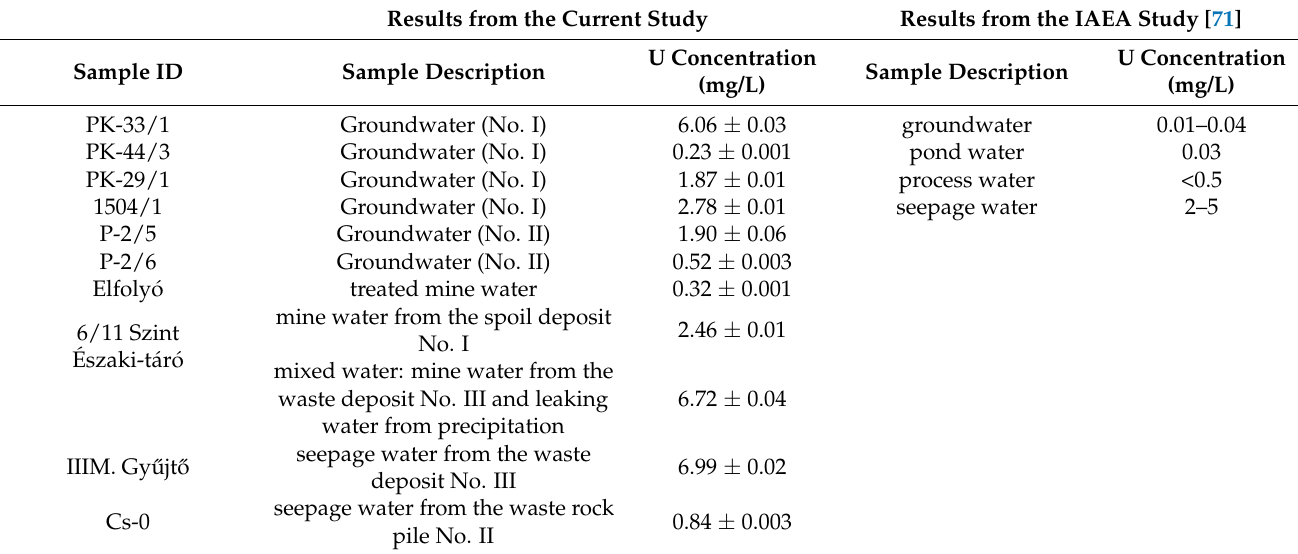
Table 3. Uranium concentrations for water